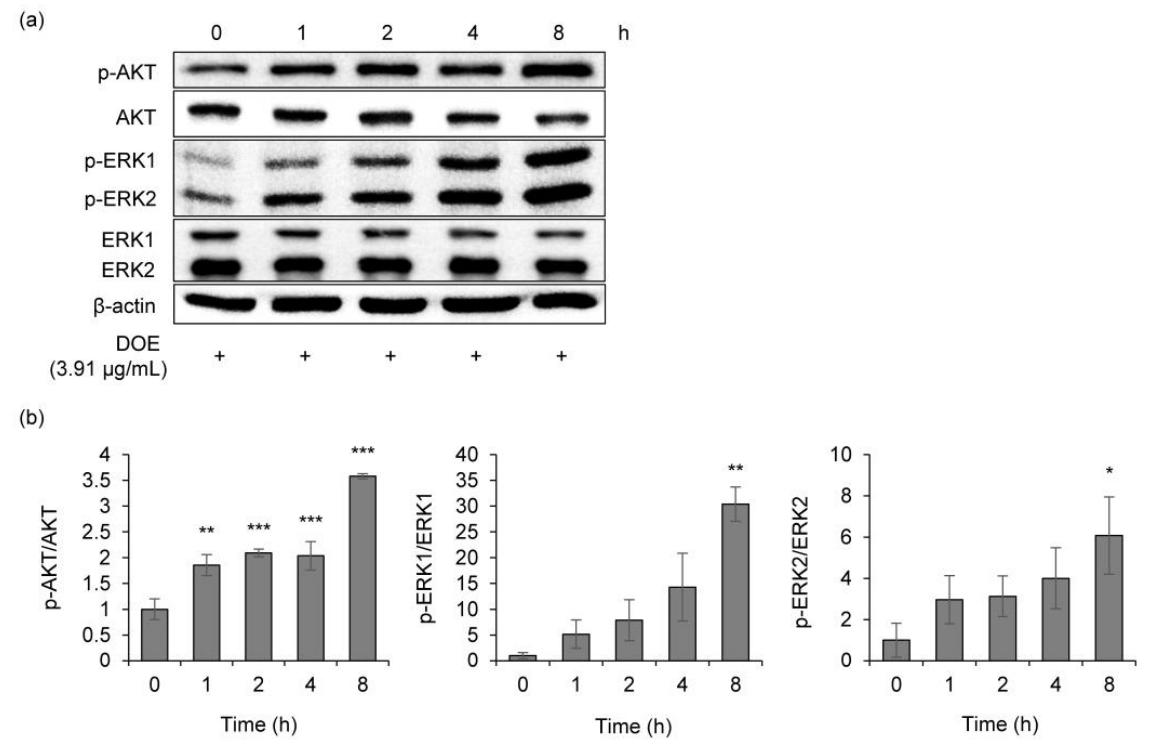
Figure 6. ( a ) Effects of the DOE on the protein expressions of p-AKT, AKT, p-ERK1/2, and ERK1/2 in B16F10 cells. B16F10 cells were treated with 3.91 µ g/mL of DOE. Protein expressions of p-AKT, AKT, p-ERK1/2, and ERK1/2 were analyzed by Western blotting. Equal protein loading was confirmed using β -actin antibody. ( b ) Protein levels of p-AKT, AKT, p-ERK1/2, and ERK1/2. The relative level of each protein was calculated based on the intensity of β -actin protein and CREB. * p < 0.05, ** p < 0.01, and *** p < 0.001 vs. 0 h.